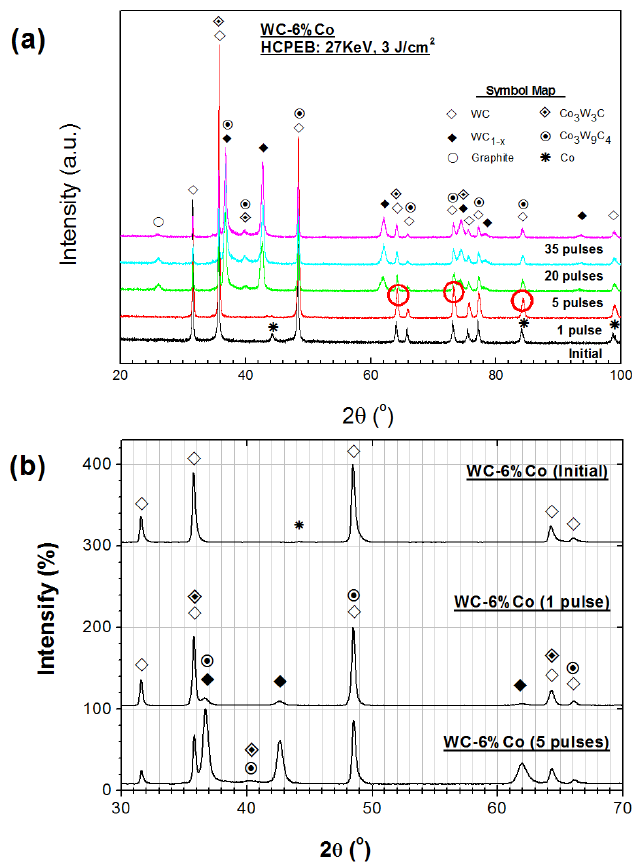
Figure 2. ( a ) XRD patterns of WC ‐ 6% Co hard alloy and ( b ) the detailed XRD traces before and after high ‐ current pulsed electron beam (HCPEB) irradiation.